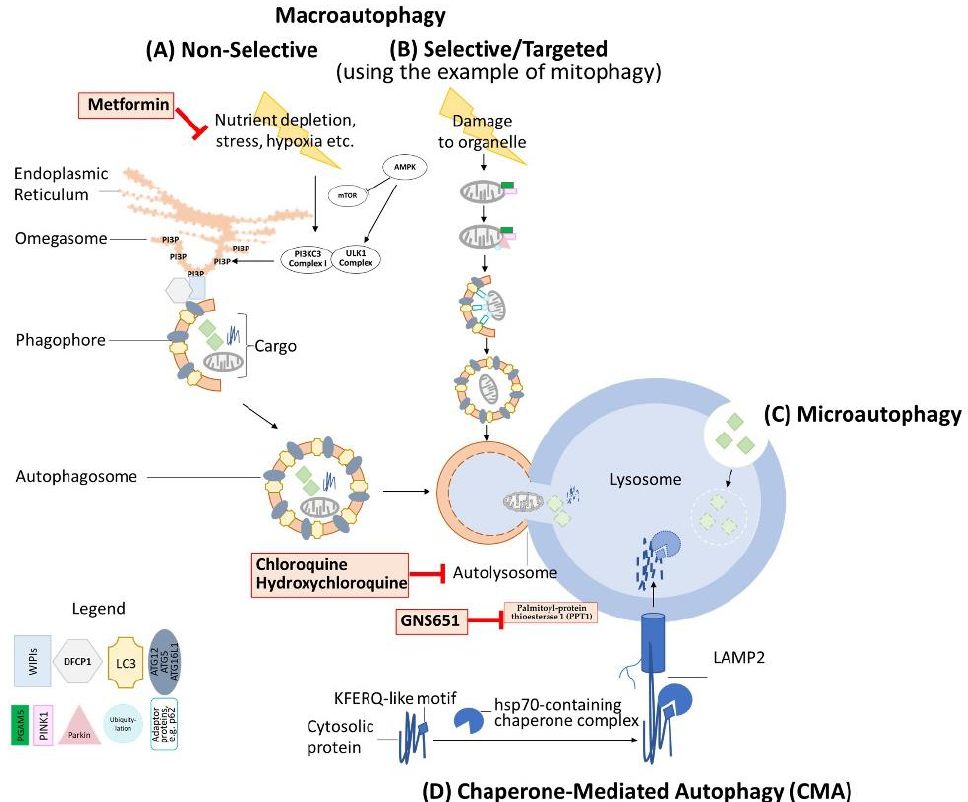
Figure 1. Illustration of micro/macro/chaperone-mediated autophagy. ( A ) Non-selective macroau- tophagy (unspecific engulfment of cytosolic components and organelles and their degradation for the purpose of energy production and generation of basic components). ( B ) Selective/targeted macroautophagy using the example of mitophagy. ( C ) Microautophagy. ( D ) Chaperone-mediated autophagy. Autophagy-modulating drugs that have been applied in clinical trials for the therapy of distinct cancer entities, as reviewed in this current manuscript, are indicated at their site of action in the process of